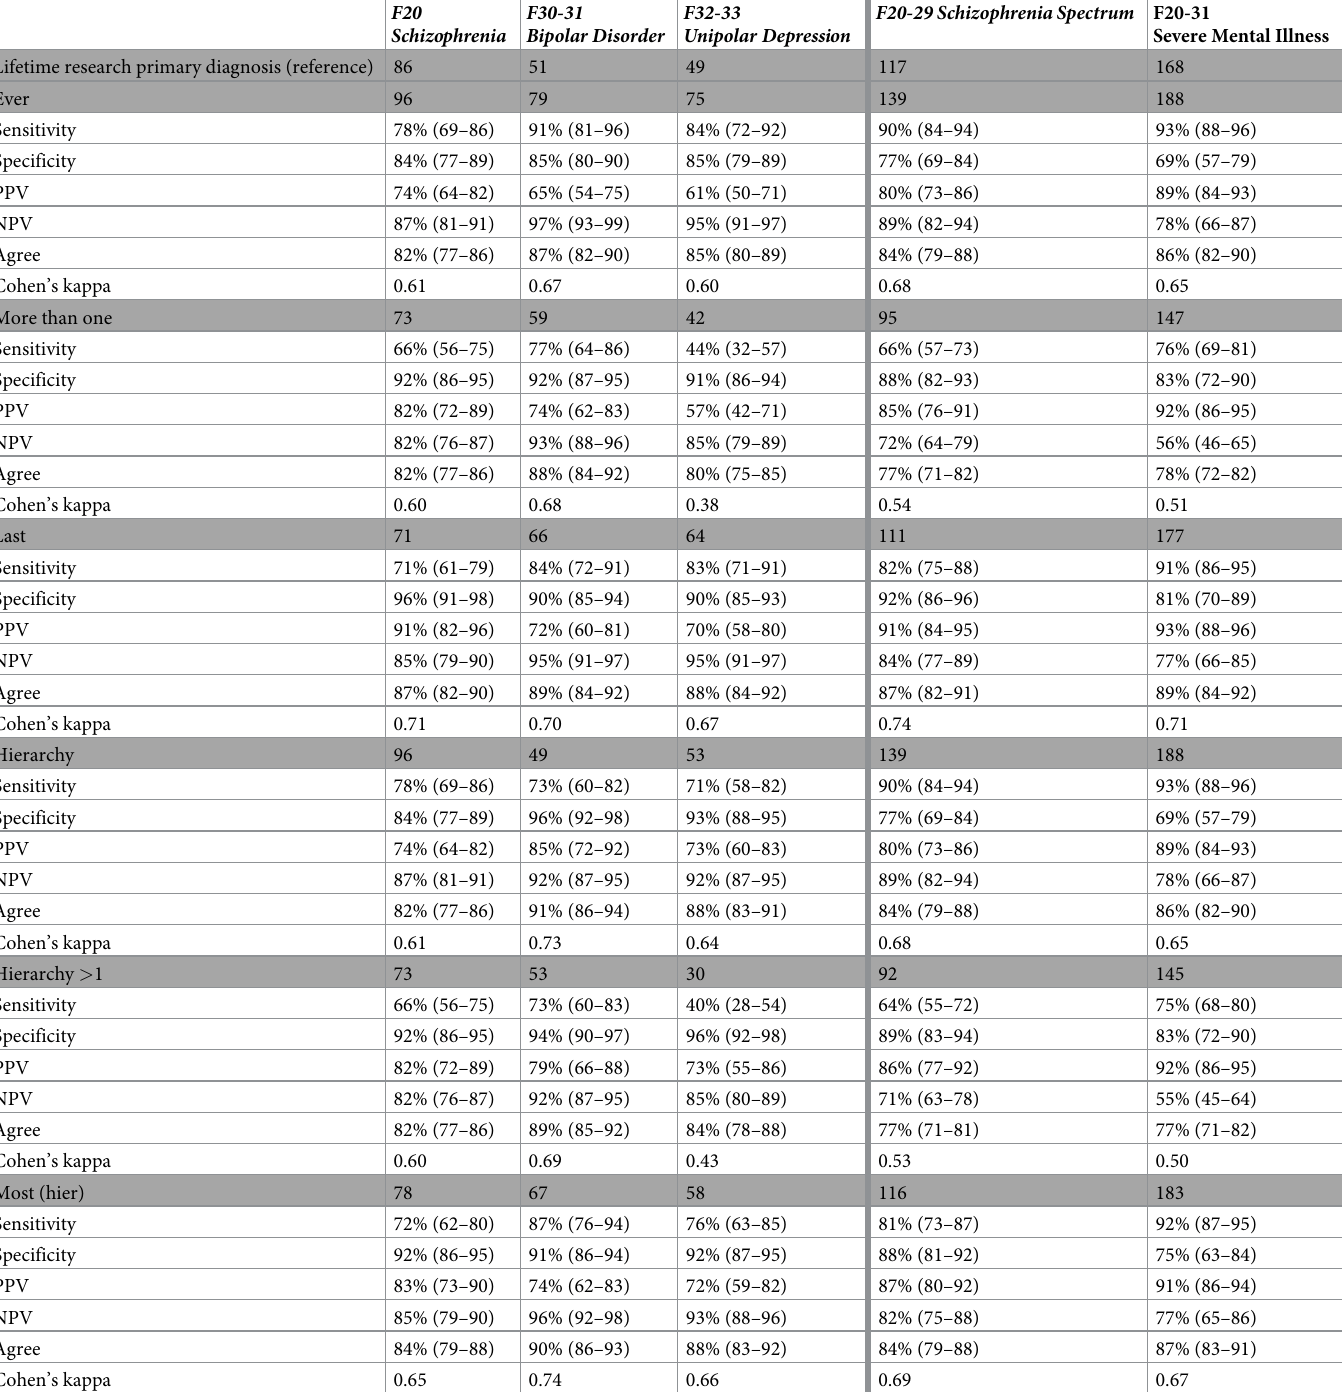
Table 5. Accuracy statistics for algorithms to predict lifetime research diagnosis from multiple HES records, based on review of 246 cases. Numbers of cases given for each diagnostic group predicted by stated algorithm (explained in methods). PPV = positive predictive value, NPV = negative predictive